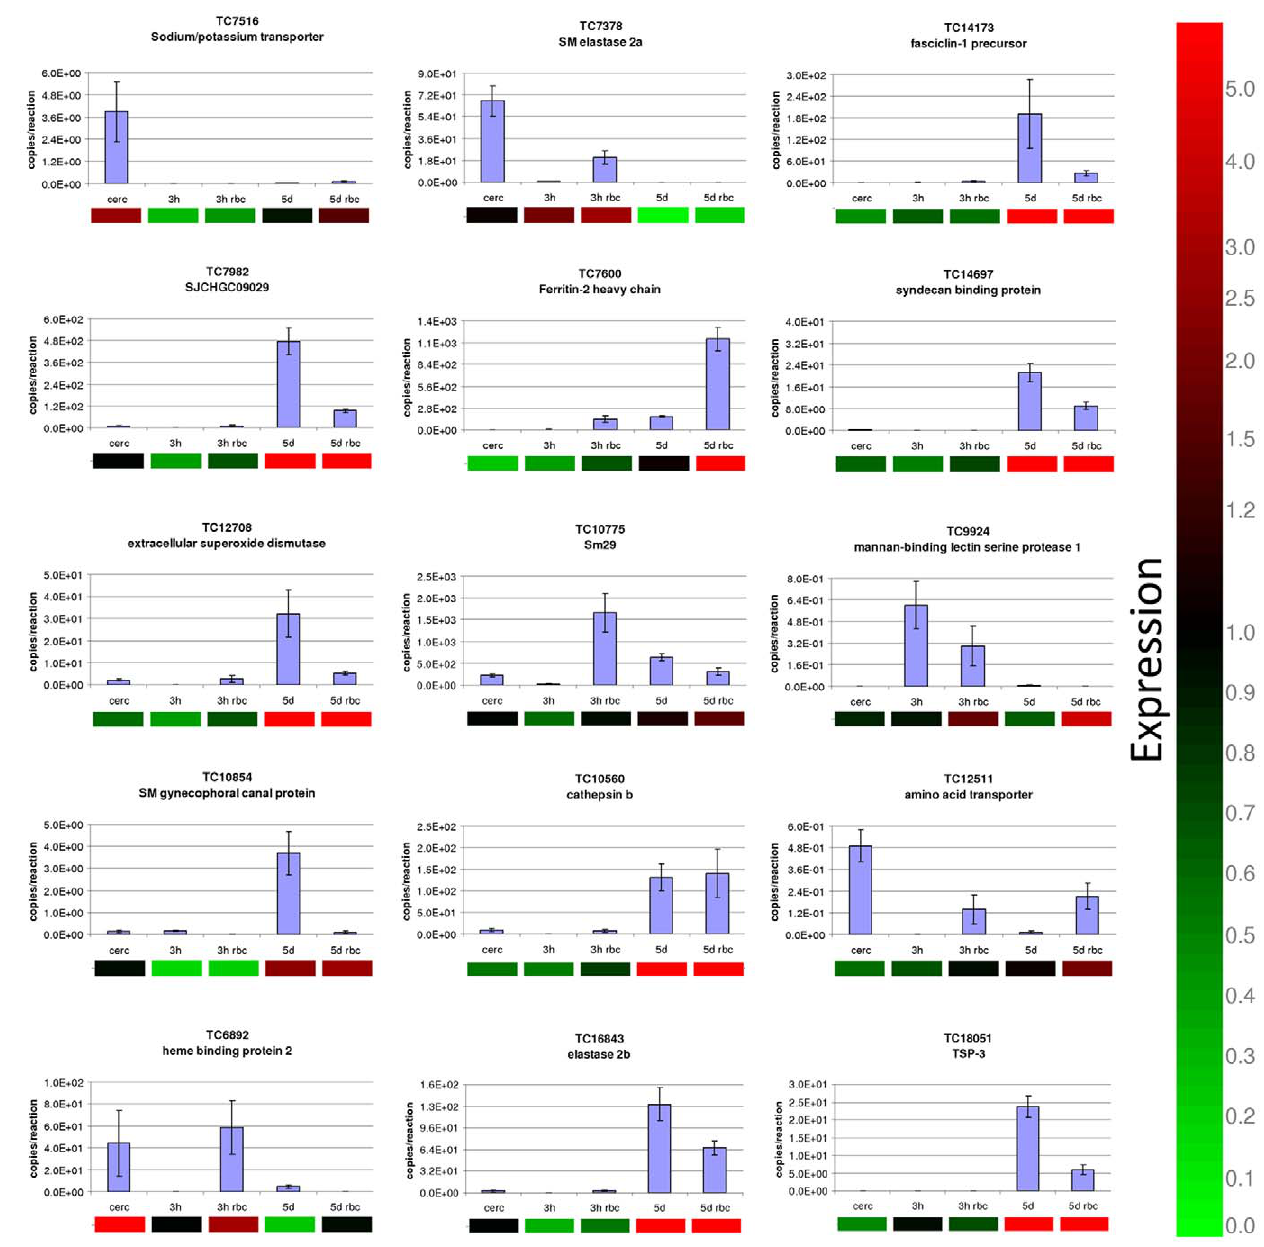
Figure 5. Validation of a subset of differentially expressed genes in 3 h and 5 day schistosomula of S.mansoni cultured in the presence or absence of erythrocytes. Quantitative real time PCR data, expressed as copy number per reaction, are presented as bar graphs, while the corresponding microarray data are shown below the graphs as heat maps. Microarray gene expression is indicated by up-regulation (red), down-regulation (green) or unchanged (black). The microarray data were not normalised to any